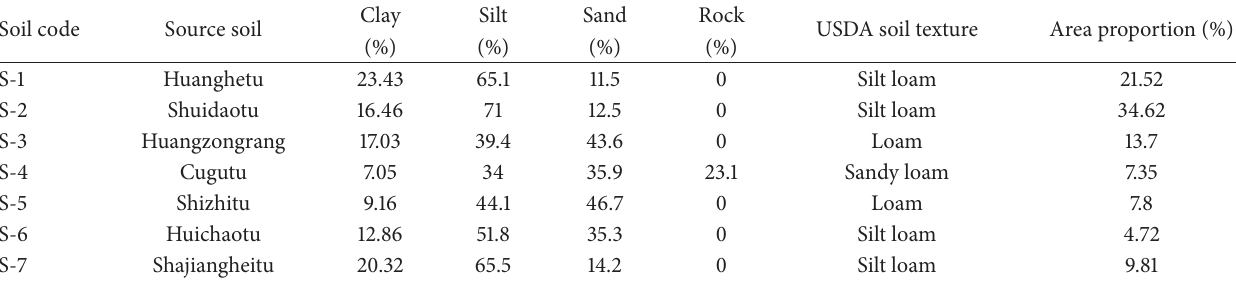
Table 1: Soil classification and its area proportions in the upper Huai River basin.